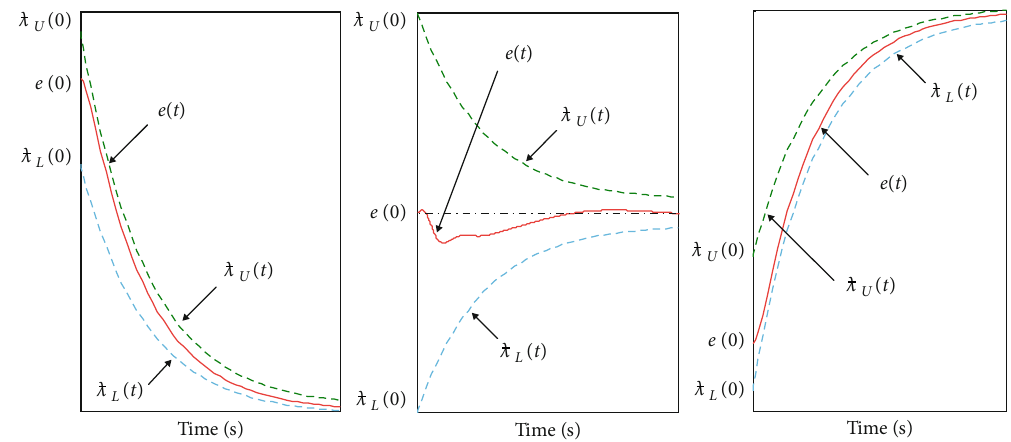
Figure 3: Graphical illustration of the novel prescribed performance de fi nition (12): (a) e ð 0 Þ > 0 ; (b) e ð 0 Þ = 0 ; (c) e ð 0 Þ < 0